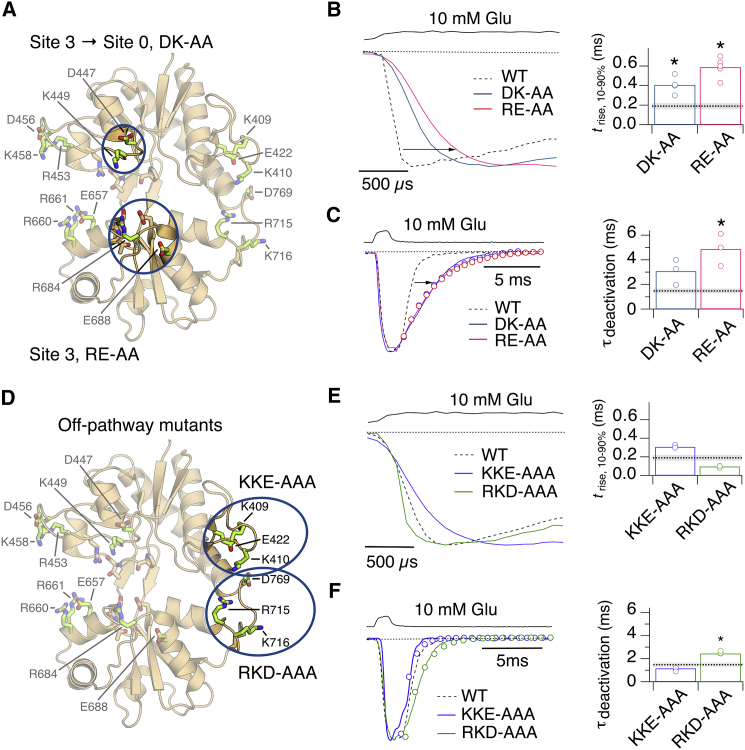
Activation and Deactivation of Receptors with Mutations in Pathway 3 and Off-Pathway Mutants(A) The blue ovals indicate residues of the LBD that interact with the ligand. K449 participates in transferring the ligand from metastable site 3 to site 0 (Figure 2B). D447 and K449 were mutated to alanine (DK-AA). R684 participates in site 3, and two residues, R684 and E688, were separately mutated to alanine (RE-AA).(B) The activation of receptors in response to a long pulse of 10 mM glutamate was slower than WT GluA2 (dashed line) for both DK-AA (blue trace) and RE-AA (red trace). The upper black trace shows solution exchange. Individual 10%–90% rise times are plotted in the right panel with the mean value for WT GluA2 indicated by a dashed line and standard error shaded in light gray. Asterisks indicate p < 0.01 versus WT GluA2, t test, n = 3–6.(C) Deactivation of DK-AA and RE-AA mutants in response to a 1 ms pulse of 10 mM glutamate with color coding as in (B). Monoexponential fits are represented by open circles. Individual deactivation decay constants are plotted in the bar graph (right). The asterisk indicates p < 0.05 versus WT GluA2, t test, n = 3–6.(D) Blue ovals indicate positions in the LBD of two triple-alanine mutants, located away from the binding pathways (Figure 2A). One set of off-pathway mutants is located in Lobe 1 (K409A-K410A-E422A, KKE-AAA) and one set in Lobe 2 (R715A-K716A-D769A, RKD-AAA) (Figure 4A).(E) Left panel shows activation of receptors by long pulses of 10 mM glutamate. Responses for the KKE-AAA (blue trace) and RKD-AAA (green trace) mutants are overlaid with a typical WT GluA2 response as in (C), with individual rise times plotted in the right panel. Asterisk indicates p < 0.05.(F) Left panel shows deactivation of off-pathway mutants following a 1 ms pulse of 10 mM glutamate. Color coding as in (E). Individual rise times are plotted in the right panel. Asterisk indicates p < 0.01.See also Figure S7 and Table S3.